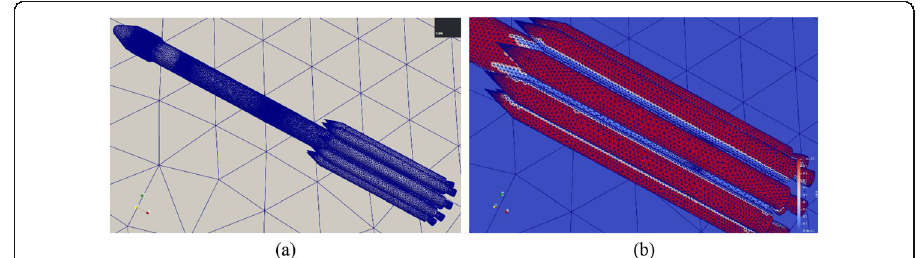
Fig. 7 The hybrid mesh of a rocket model: ( a ) The surface mesh; ( b ) Close-up views of the color map of gap distances ( d G i )